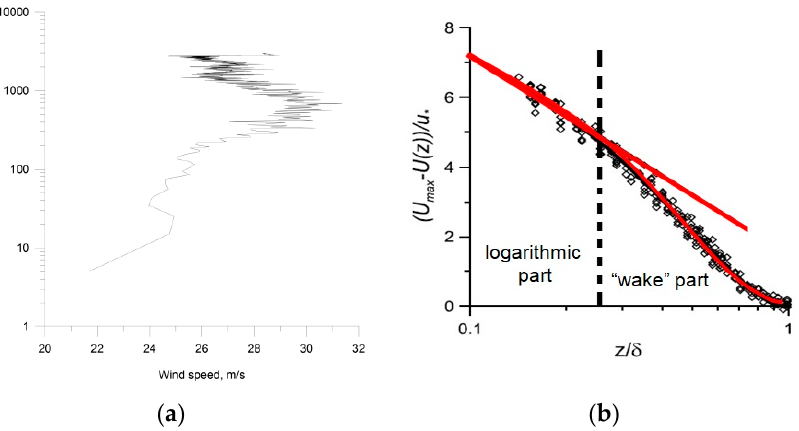
Figure 2. An example of a wind speed profile averaged over the profile groups for hurricane Katrina 2005/08/27 ( a ); airflow velocity profiles measured by the authors in the aerodynamic flume at different wind speeds over the waves in self-similar variables (reproduced from [28], with permission from John Wiley & Sons, 2012) ( b ). The straight solid line is the logarithmic approximation.